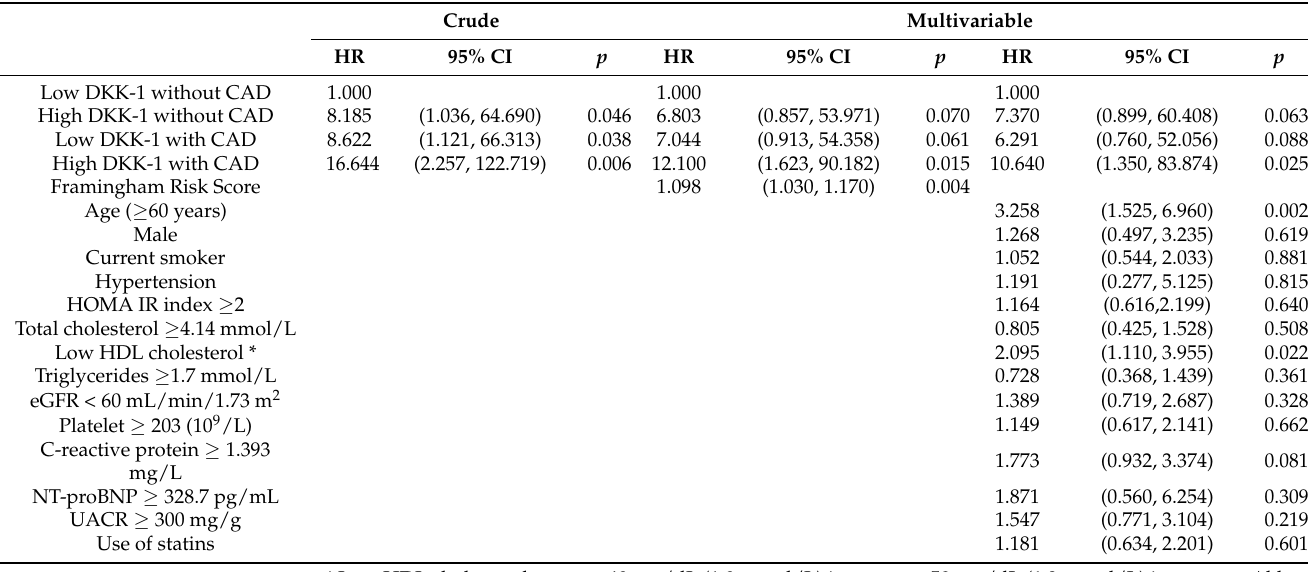
Table 3. Cox proportional hazard regression models for the association between risk factors and major adverse cardiac